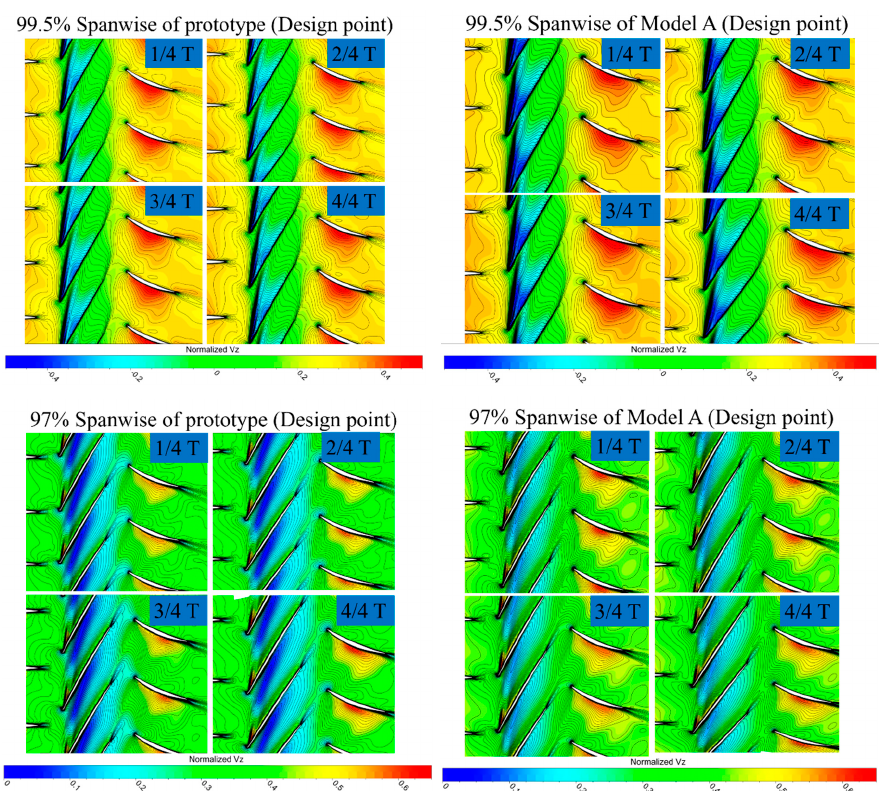
Figure 13. Transient axial relative velocity of the prototype and model A at 99.5% and 97% spanwise at design point. design point. Processes 2020 , 8 , x FOR PEER REVIEW